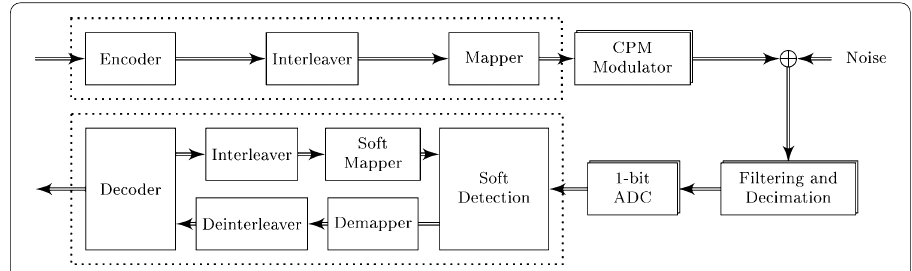
Fig. 1 Extended discrete system model, 1-bit quantization, oversampling and coding blocks with an iterative decoding